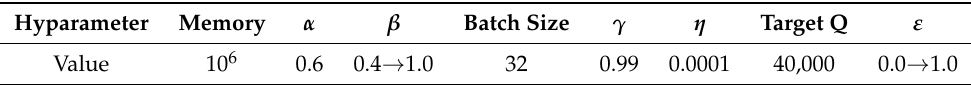
Table 1. The main hyperparameters for every baseline. There are some other hyperparameters that are the same as ATDC-PER. All tasks use the same hyperparameter settings. Hyparameter